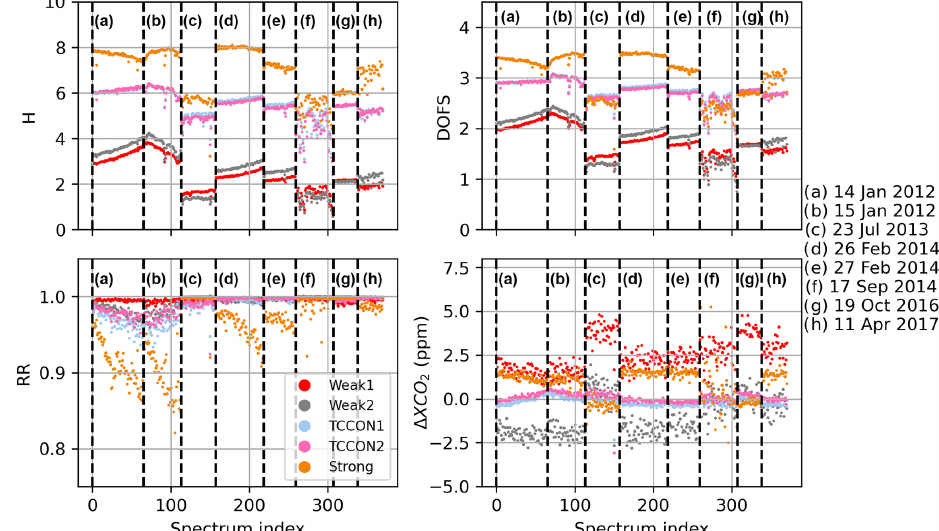
Figure 12. Shannon information content (top left), degrees of freedom for signal for the CO 2 profile (top right), and ratio of residuals (bottom left), and profile minus scaling retrieval XCO 2 (bottom right) for all Lamont spectra coincident within ± 1h of the AirCore last sampling time for AirCores launched on the dates indicated on the right. Each new date is marked by a vertical dashed line.